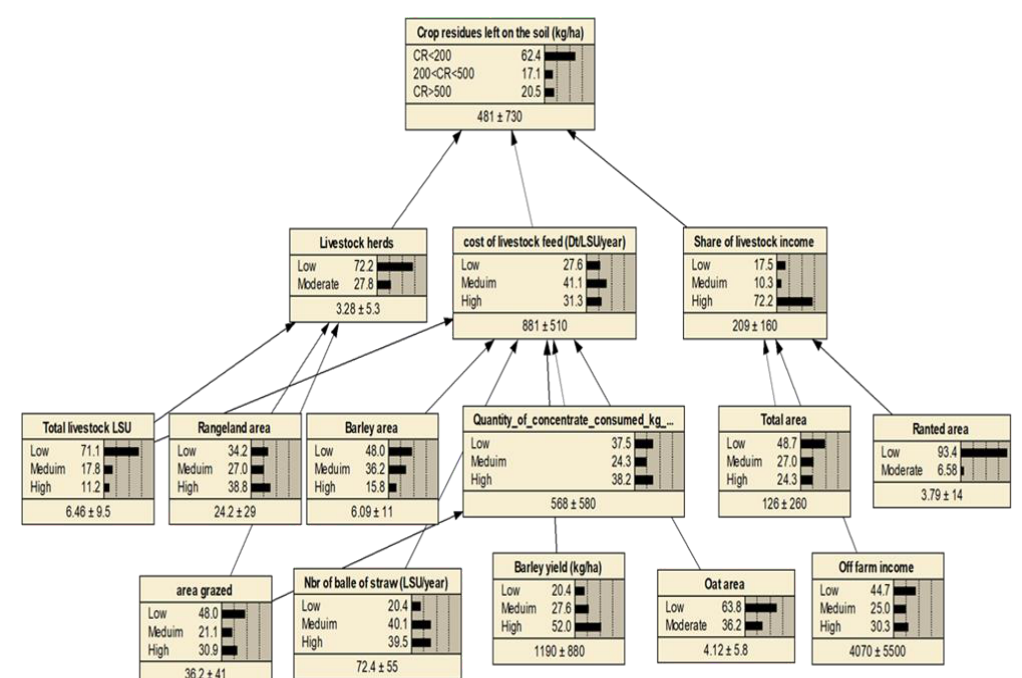
Figure 5. BBN learning results with factors driving different residue management patterns. Sensitivity analysis conducted over the child node “CR left on the soil” shows that the residue management pattern is the most sensitive to livestock variables, including the share of livestock in the total farm income, size of the livestock herd, and cost of livestock feed (Figure 6). This demonstrates that farmers in the studied cereal–sheep production systems are looking at CA using a “livestock lens.” Solutions to enhance soil fertility need to be channeled through enhanced (or alternative) feeding systems. Figure 6. Sensitivity analysis of crop residues left on the soil.